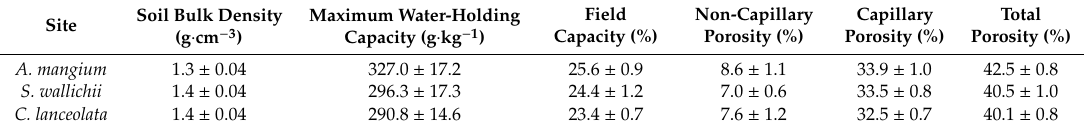
Table 2. Physical properties, water holding capacity, and storage performance of three plantation soils.